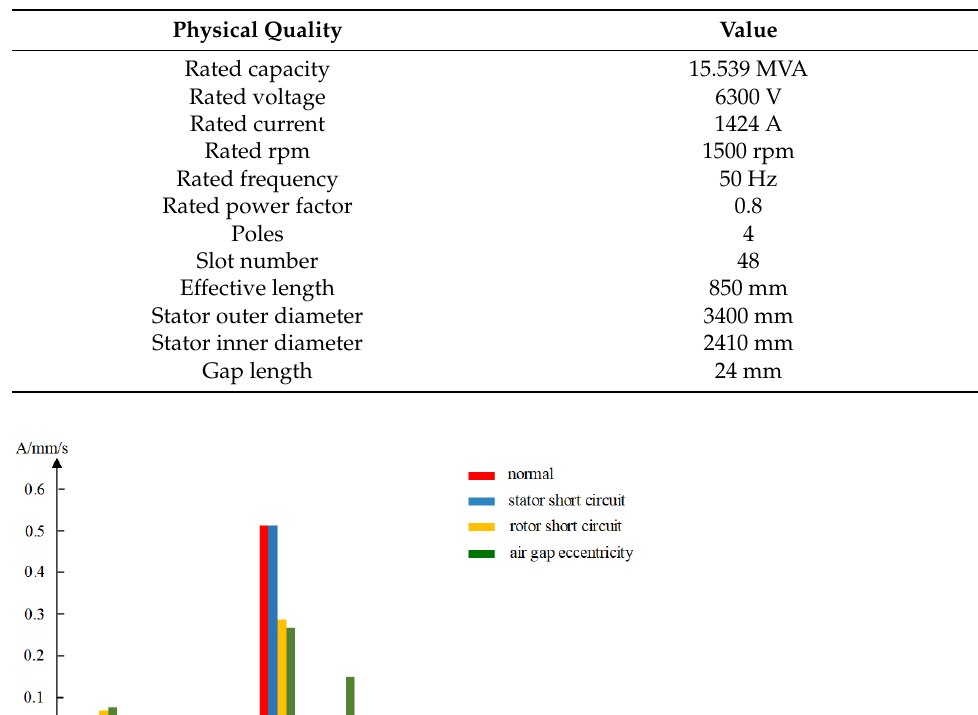
Table 1. Parameters of the generator.